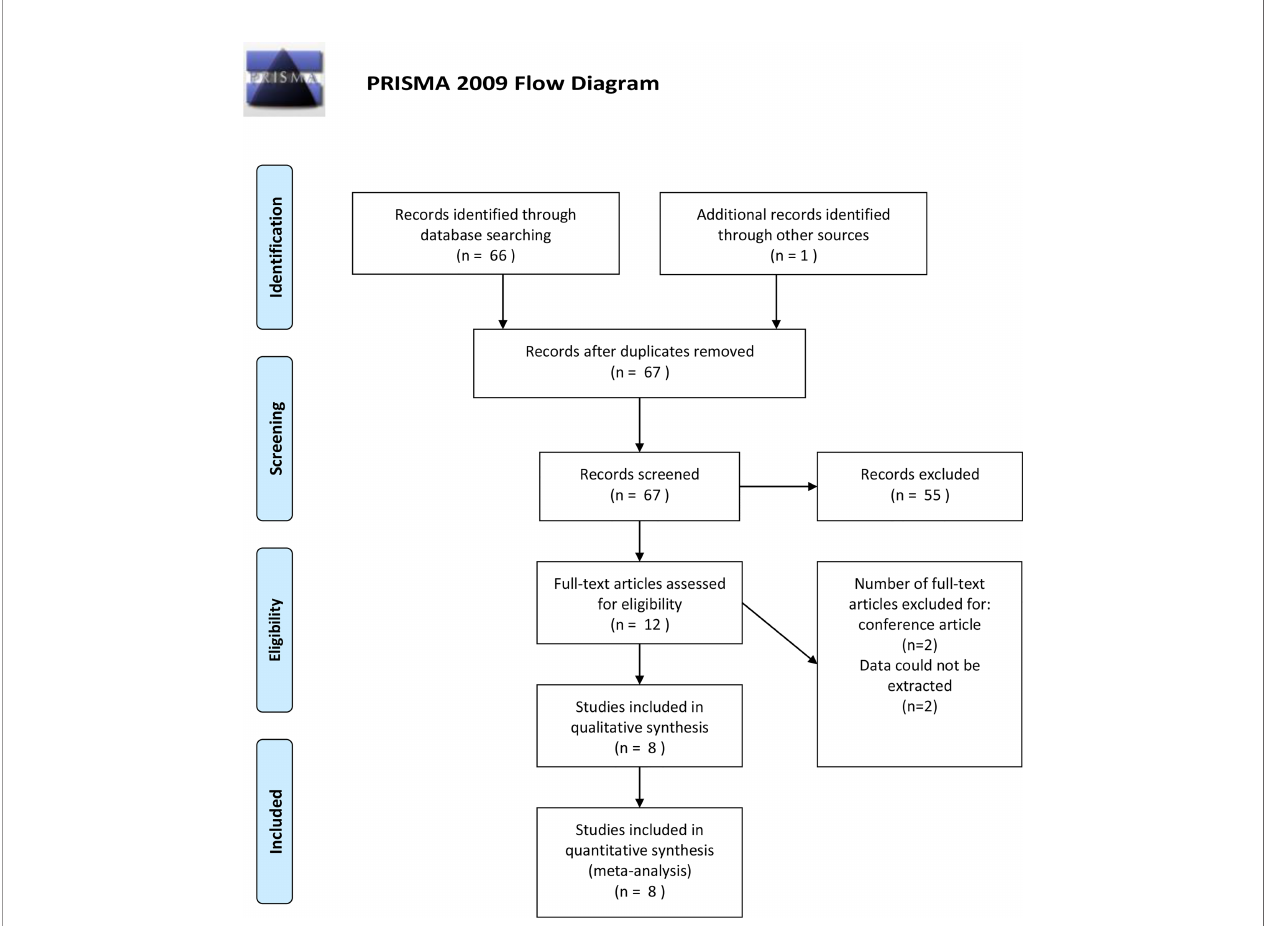
FIGURE 1 | PRISMA fl ow diagram of study selection for the systematic review and